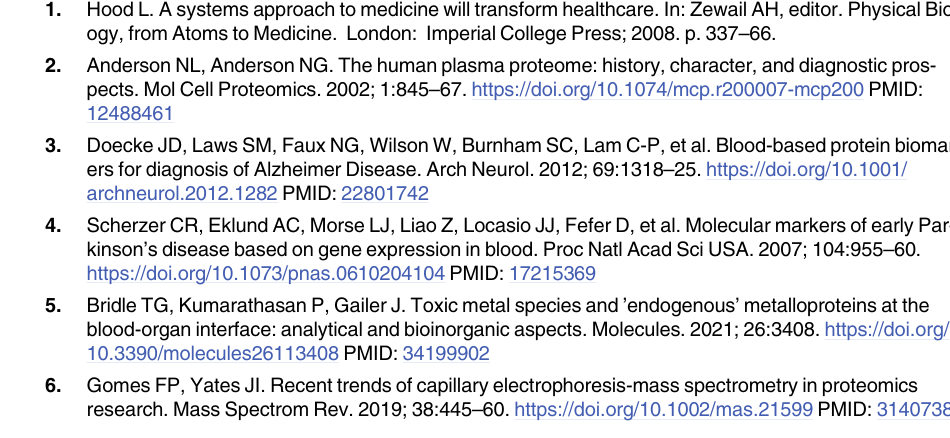
S2 Fig. Zn recovery for rabbit plasma after SEC-ICP-AES analysis. (TIF) S3 Fig. SEC-ICP-AES derived area counts for the Fe peak corresponding to the Hp-Hb complex in the three groups.